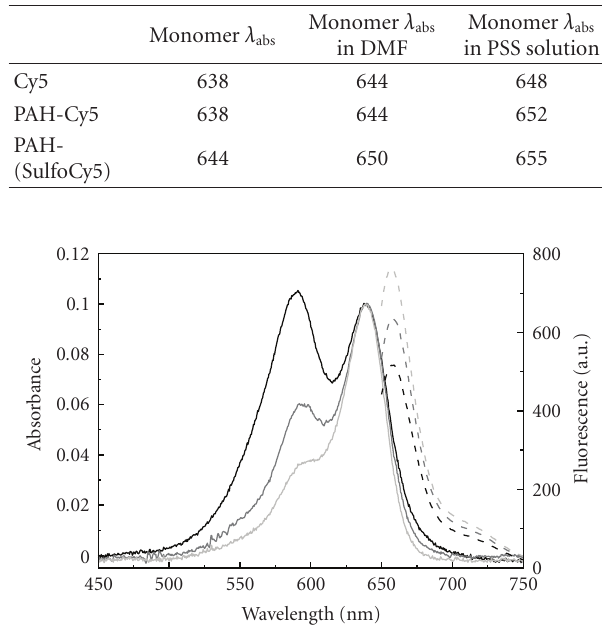
Figure 6: Absorption (solid lines) and fluorescence spectra (dashed lines) of PAH-Cy5 A (black), PAH-Cy5 B (grey) and Cy5 free dye (light grey) measured in aqueous solution. The concentration of the solutions is set to the absorption maximum. The fluorescence spectra are taken with λ ex = 638nm and a slit width of